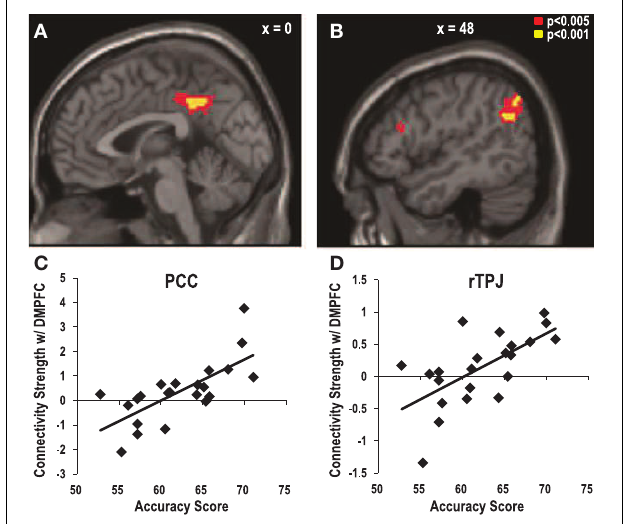
FIGURE 4 | The strength of the functional connectivity with the DMPFC associated with higher accuracy in estimating the preferences of the targets. The psychophysiological interaction with DMPFC activity during correct vs. incorrect estimation trials that increased as a function of the individual estimation accuracy scores were observed in posterior cingulate cortex [PCC; (A) : x = − 2, y = − 44, z = 40, Z = 3 . 73, corrected, p < 0.05] and the right temporoparietal junction [TPJ; (B) : x = 48, y = − 60, z = 28, Z = 3 . 55, corrected, p < 0.05]. Scatter plots of the connectivity strength between the DMPFC and (C) the PCC, and (D) the right TPJ as a function of the individual estimation accuracy scores.